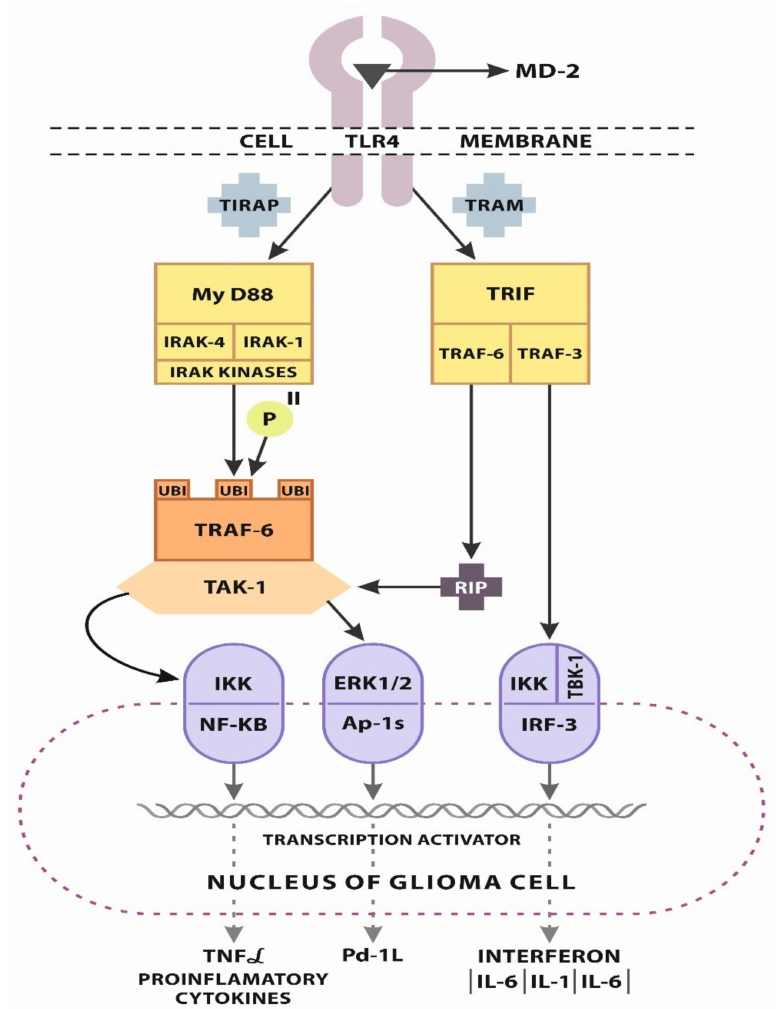
Figure 1. Toll-like-receptor (TLR)-4, after activation by pathogen-associated molecular patterns (PAMPs) and danger-associated molecular patterns (DAMPs) supported by myeloid di ff erentiation factor-2 (MD-2), initiates downstream signaling in two major ways. The first is the MyD88-dependent pathway connected with toll-interleukin 1 receptor domain-containing adaptor protein (TIRAP) resulting in myddosome formation, a structure containing IRAK-4 and IRAK-1 kinases. Activation of IRAK-1 results in TRAF-6 induction with collateral ubiquitination and phosphorylation. TRAF-6 promotes TAK-1. Activation of TAK-1 results in IKK / NF- κ B complex formation and promotion. ERK1 / 2 kinases are also activated, which indicates activated protein-1 (Ap-1), the factor activating the transcription process. The second pathway, MyD88 -independent, connected with translocating chain-associating membrane (TRAM), leads through toll-like receptor adaptor molecule-1 (TRIF) activation resulting in TRAF-3 and TRAF-6 promotion. RIP is recruited by TRAF-6, activating RIP signaling on the TAK-1 / ERK 1 / 2 / Ap-1 axis. TRAF-3 activates IKK and TBK-1 to activate interferon regulatory factor-3 (IRF-3). IRF-3 induces interferon expression and other proinflammatory